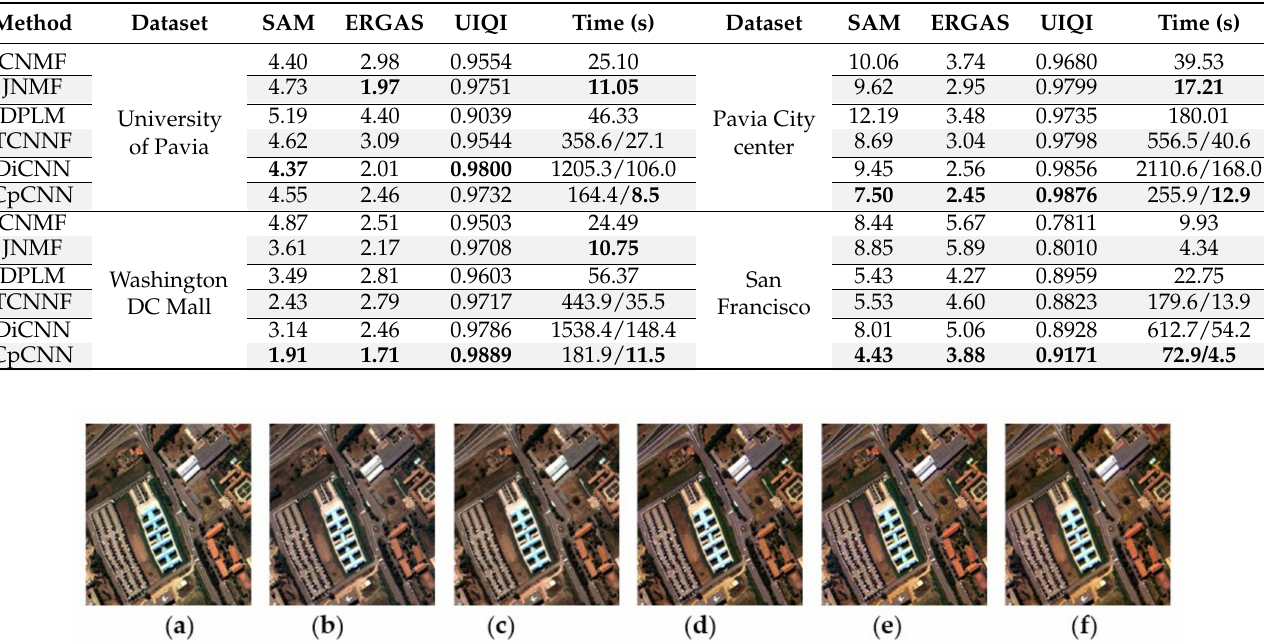
Figure 2. Fused images of University of Pavia. ( a ) coupled nonnegative matrix factorization (CNMF); ( b ) JNMF; ( c ) dictionary-pair learning method (DPLM); ( d ) two-branches CNN fusion method; ( e ) detail-injection-based CNN fusion method (DiCNN); ( f ) coupled CNN-based fusion method